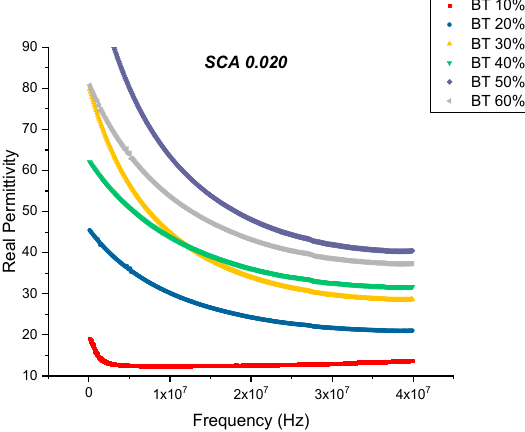
Figure 12. The real permittivity of the BaTiO 3 -epoxy composite that were fabricated using BaTiO 3 nanoparticles which were surface modified using 0.020 SCA is plotted as a function of frequency where the volume fraction of BaTiO 3 is varied from 0.1 to